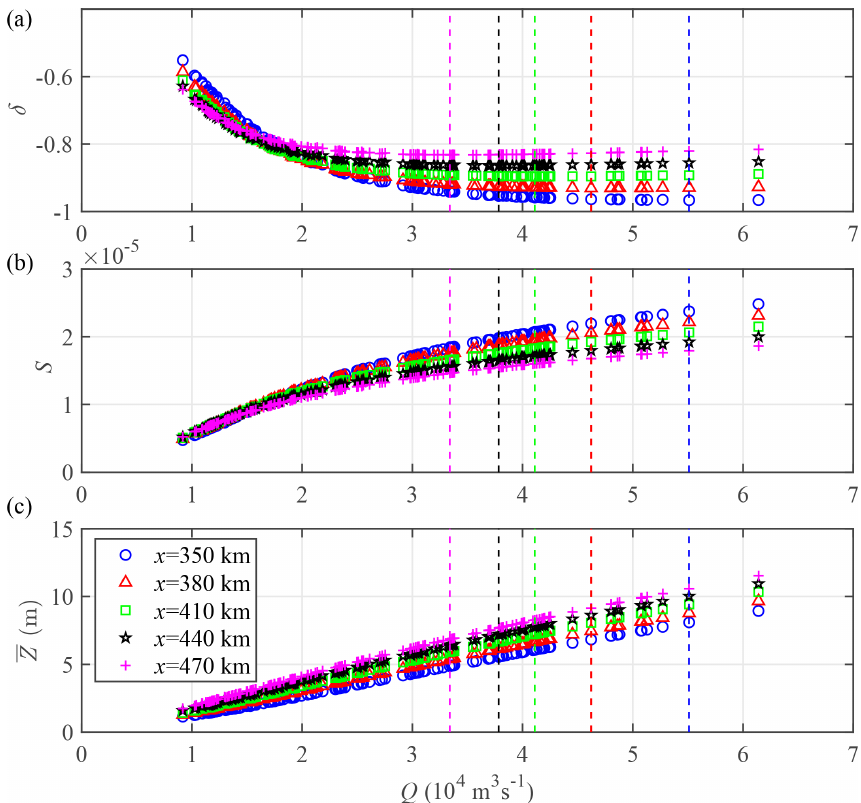
Figure 10. Relationship between the tidal damping number δ (a) , the residual water level slope S (b) , the residual water level Z (c) and the corresponding river discharge Q imposed at DT for different positions, indicated by different symbols. The dashed lines that are the same colour as the symbols are used to identify the critical river discharge for the maximum tidal damping (corresponding to the minimum value of δ in a